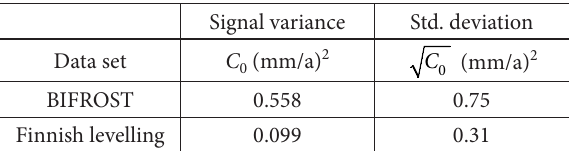
Table 3. Signal standard deviation values 0 C for tested data sets Signal variance Std. deviation Data set C 0 (mm/a) 2 C (mm/a) 2 0 BIFROST 0.558 0.75 Finnish levelling 0.099